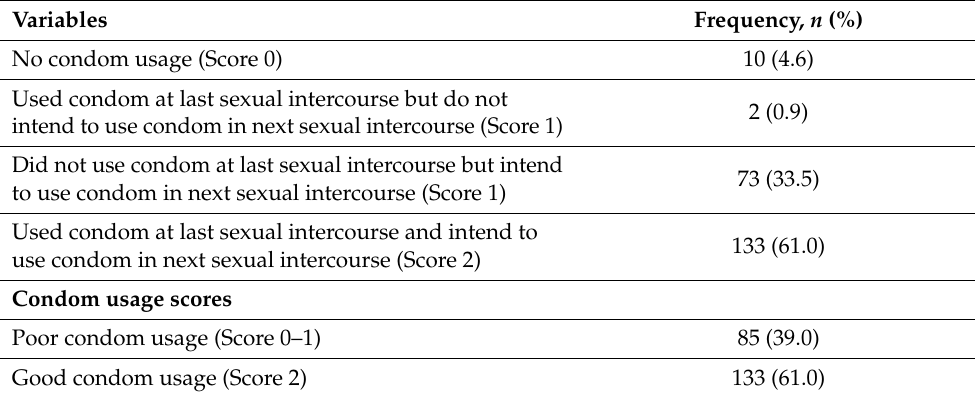
Table 2. Prevalence of good and poor condom usage, n = 218.